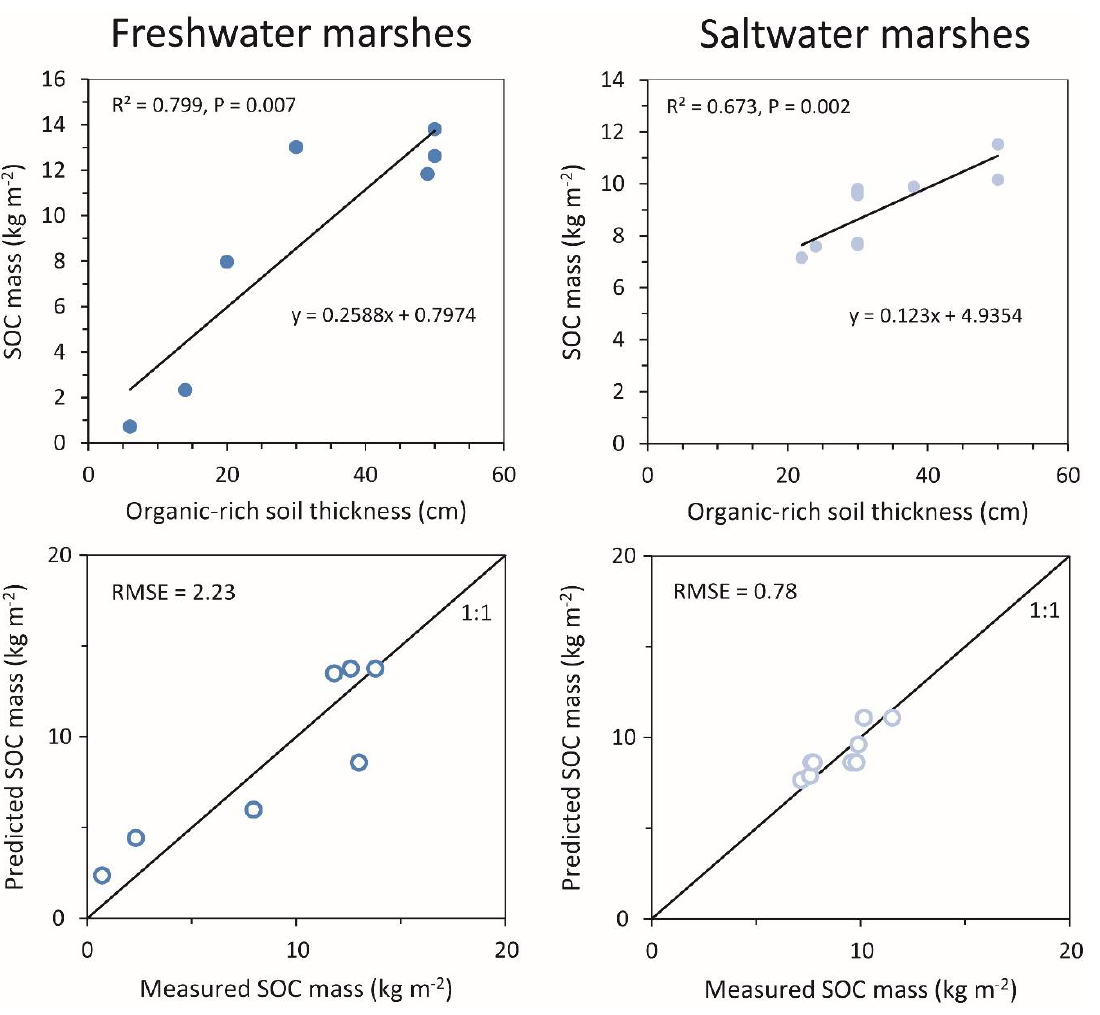
Figure 5. Relationship between the organic-rich soil layer thickness and the SOC mass (upper panel) and measured against predicted SOC mass values (lower panels) for freshwater and saltwater marshes. RMSE : root mean square